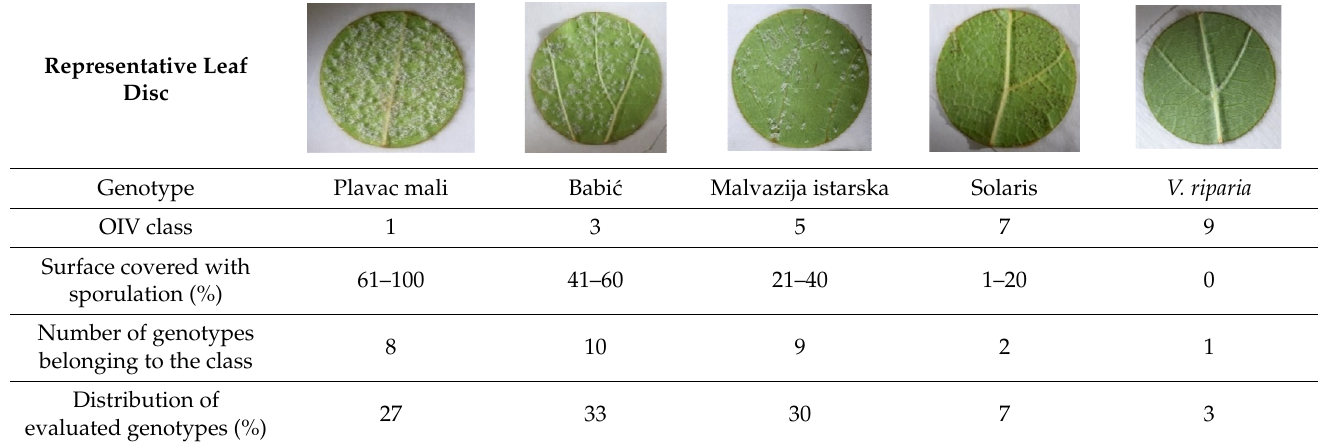
Table 2. The OIV 452-1 descriptor with images of visible differences between genotypes .